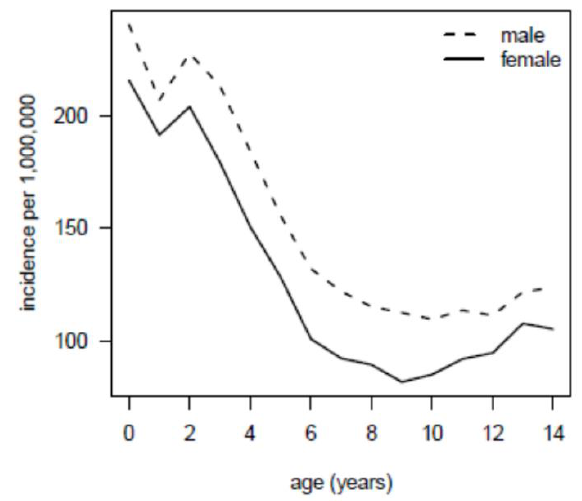
Figure 1. Cancer incidence of the German pediatric population between 1980 and 2014 stratified by gender and age, as reported by the German Childhood Cancer Registry.